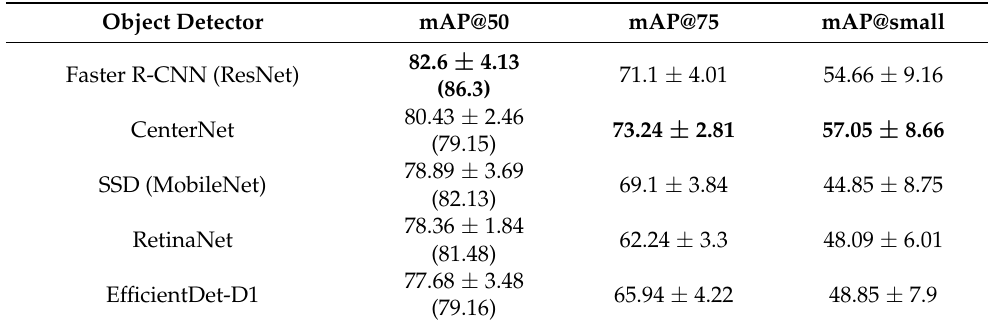
Table 4. The performance of each architecture without any data augmentation techniques. In the parentheses, the training performance is presented for mAP@50. The bold numbers correspond to the best performances.